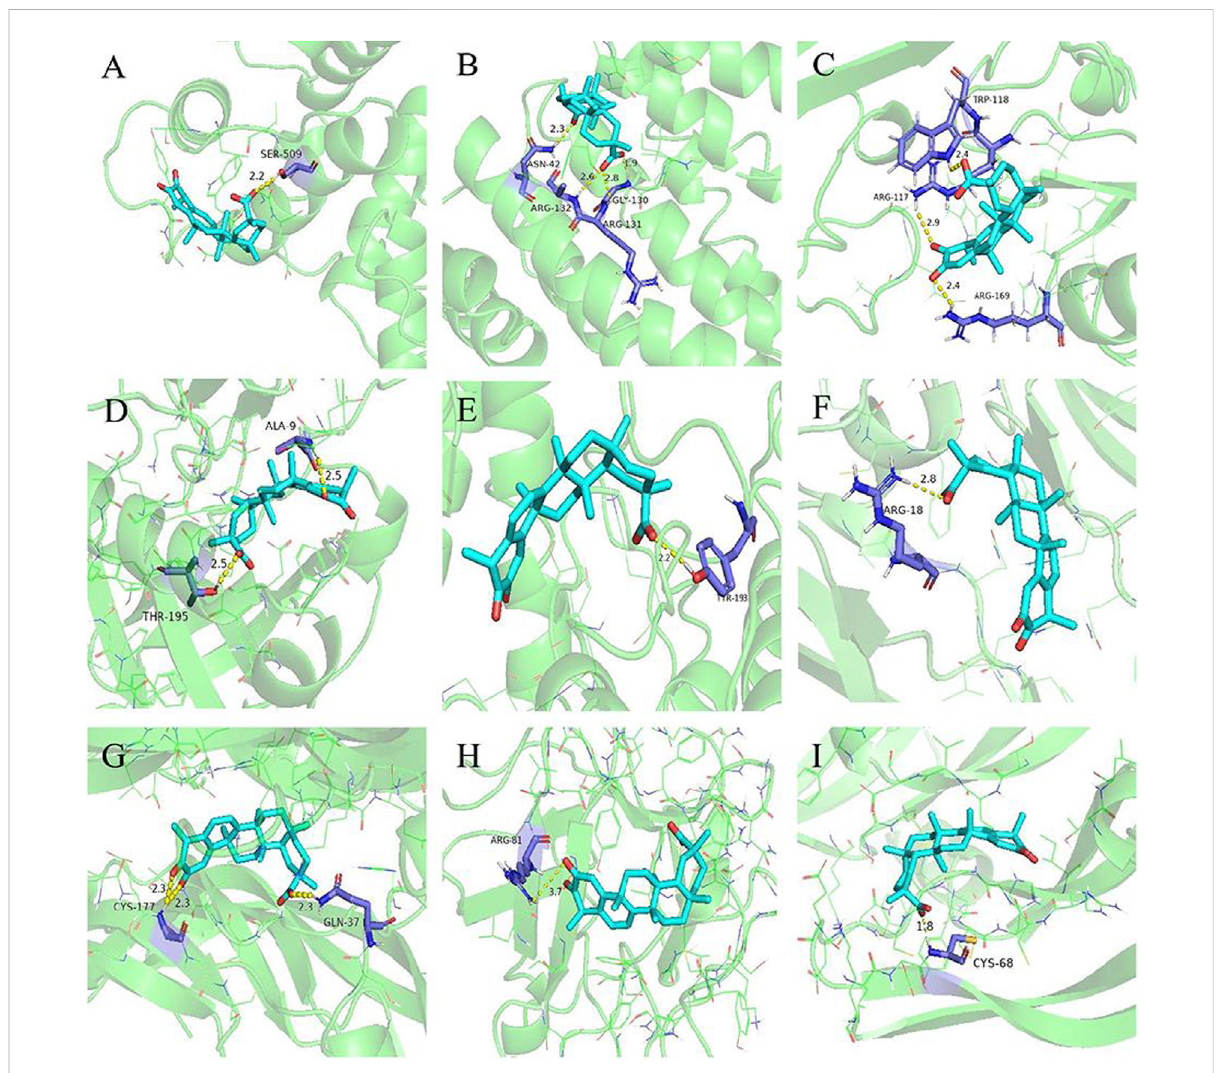
FIGURE 4 Molecular docking models of tripterine with the core targets. Proteins (A) signal transducer and activator of transcription 3 (6NUQ), (B) v-rel avianreticuloendotheliosisviraloncogenehomologA(6QHL), (C) tumournecrosisfactor(3L9J), (D) proteinkinaseB α (6NPZ), (E) mitogen-activated protein kinase 1 (3W55), (F) transforming growth factor (3KFD), (G) platelet-derived growth factor (3MJK), (H) fi broblast growth factor (2K8R), (I) vascular endothelial growth factor (1VPF) are shown interacting with a tripterine molecule, represented by a blue stick model. Lines represent residues in the binding sites. The yellow dashed lines represent hydrogen bonds, and the interaction distances are indicated next to the